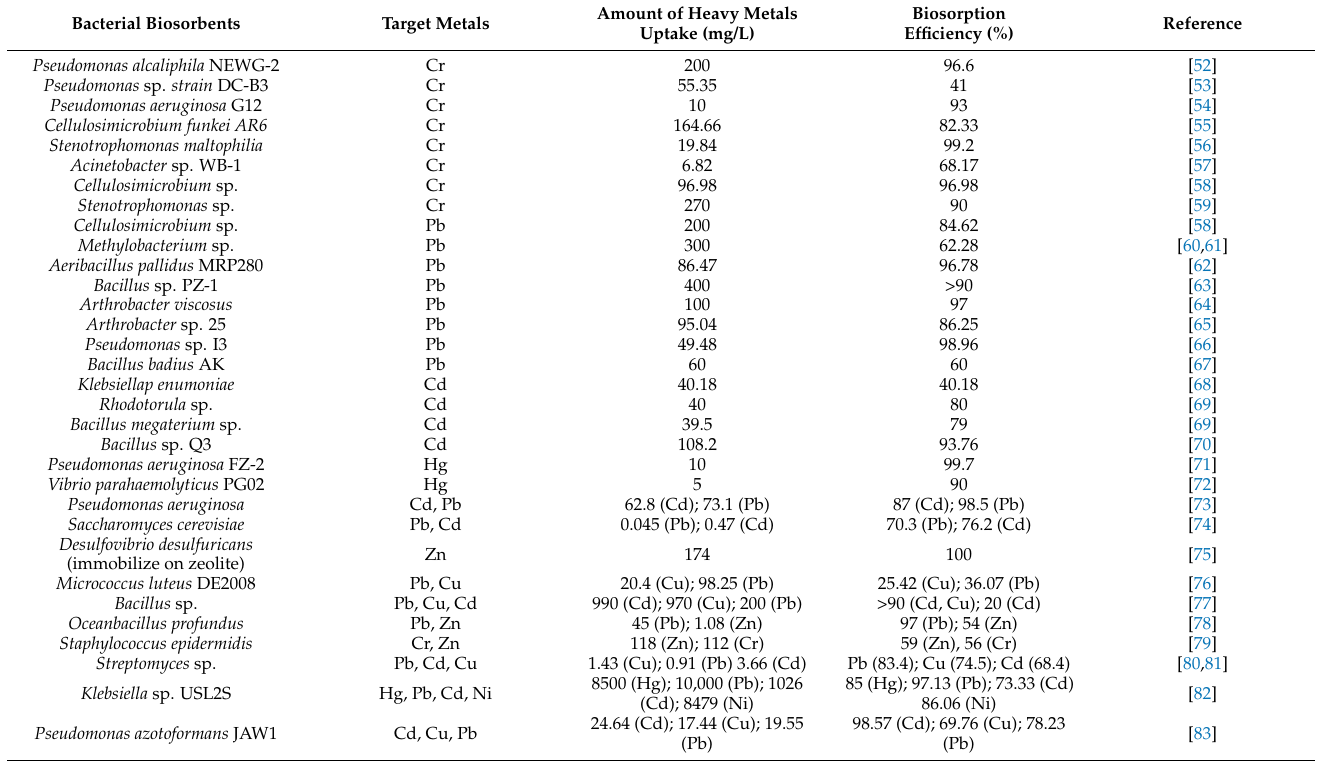
Table 2. The promising bacterial strains that can remove HMs via biosorption process. Bacterial